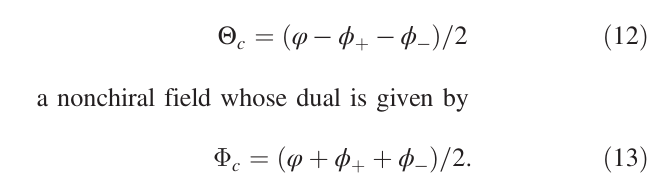
~ T symmetry yields the neutral